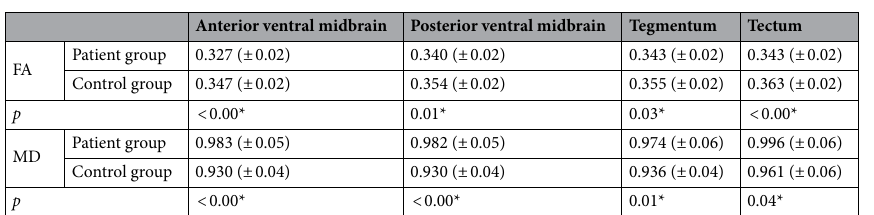
Table 2. Comparison of mean fractional anisotropy and mean diffusivity levels of four midbrain regions between the patient and control groups. Values represent mean (± standard deviation). FA: fractional anisotropy; MD: mean diffusivity. *Significant difference between the patient and control groups, p < 0.05.